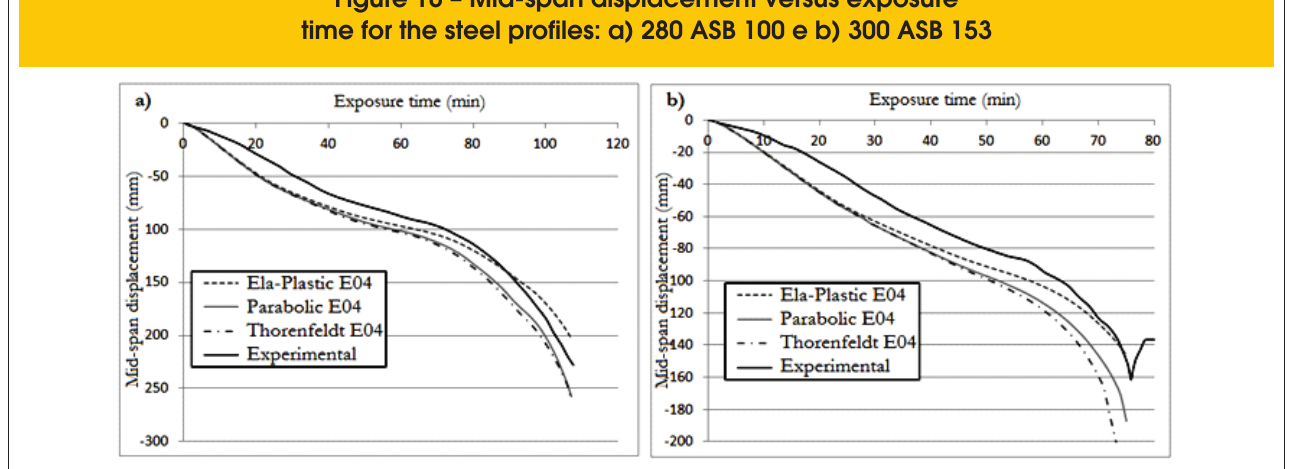
Figure 10 – Mid-span displacement versus exposure time for the steel profiles: a) 280 ASB 100 e b) 300 ASB